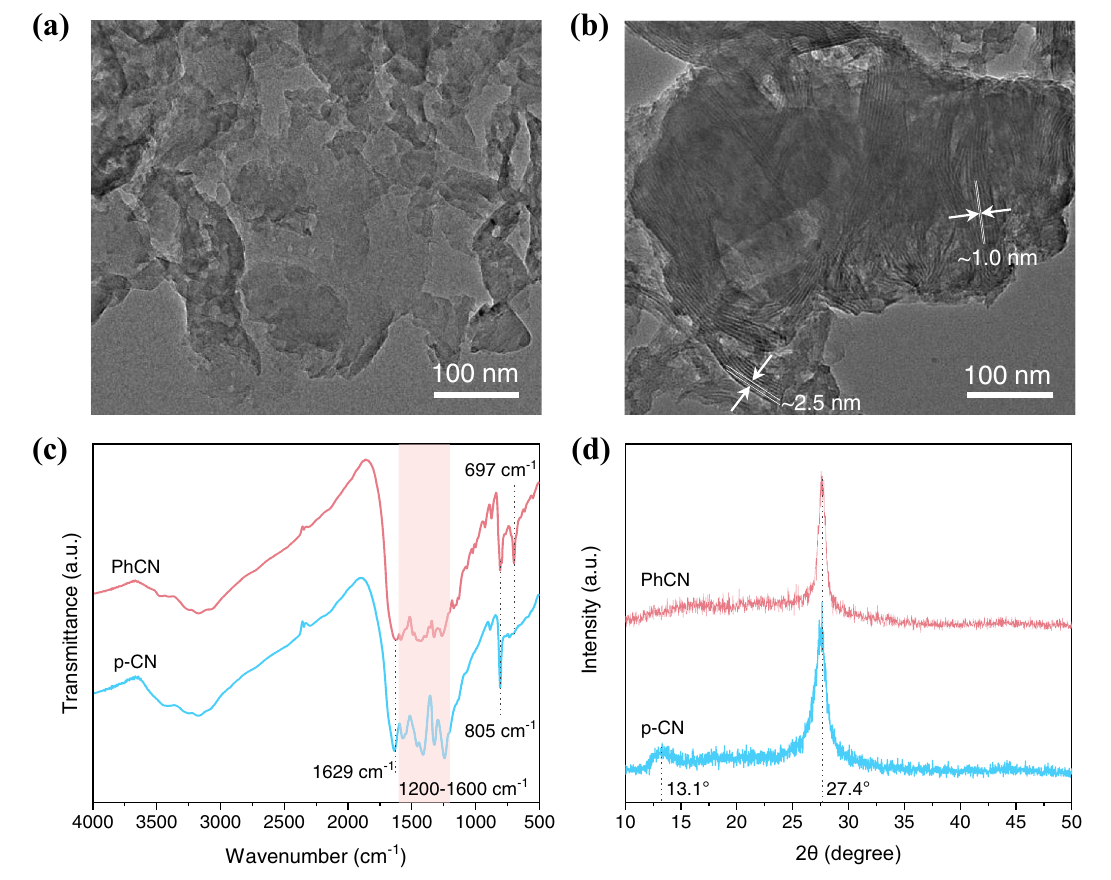
Fig. 1 | Structures of g-CN materials. TEM images of a p-CN and b PhCN. c FT-IR and d XRD patterns of p-CN and